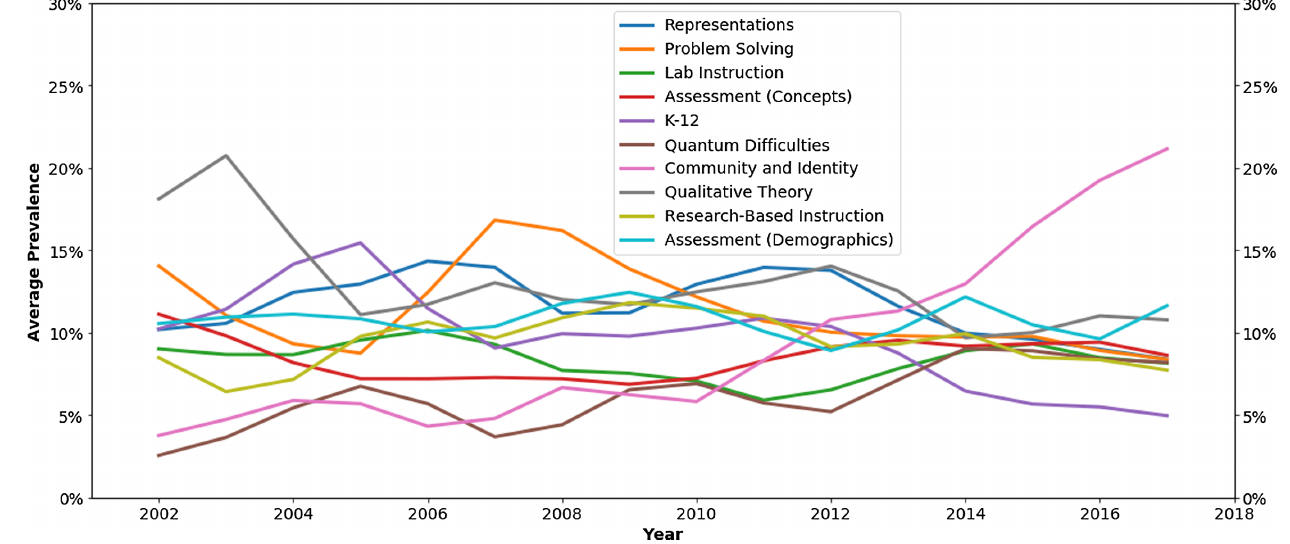
FIG. 9. Average prevalence of topics over time, smoothed using a rolling three-year